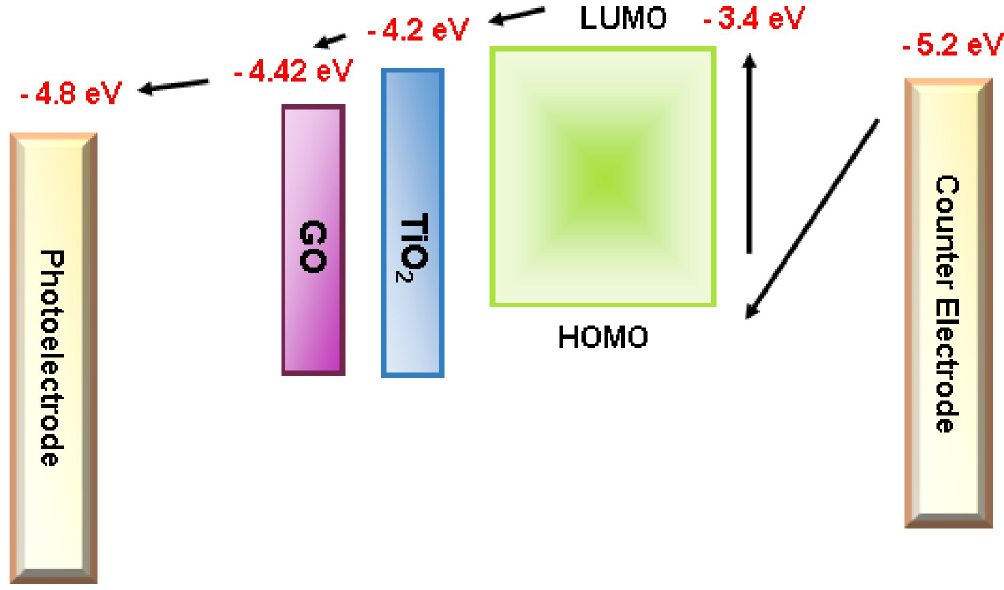
Fig 10. Electron energy level diagram of